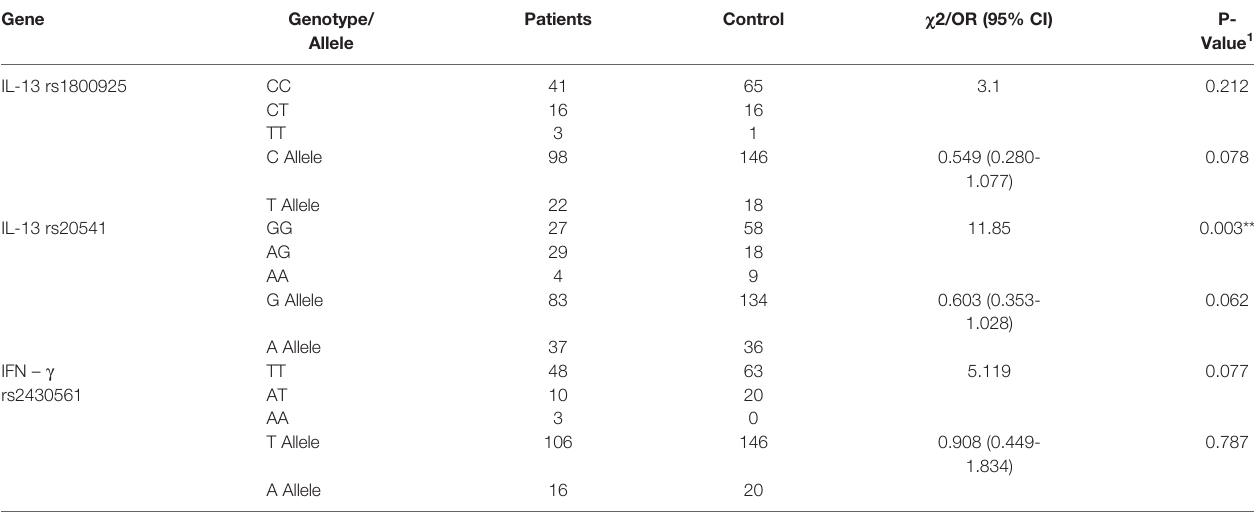
TABLE 1 | Comparison of the genotype and allele frequencies (gene polymorphisms) in the BP and control patients.